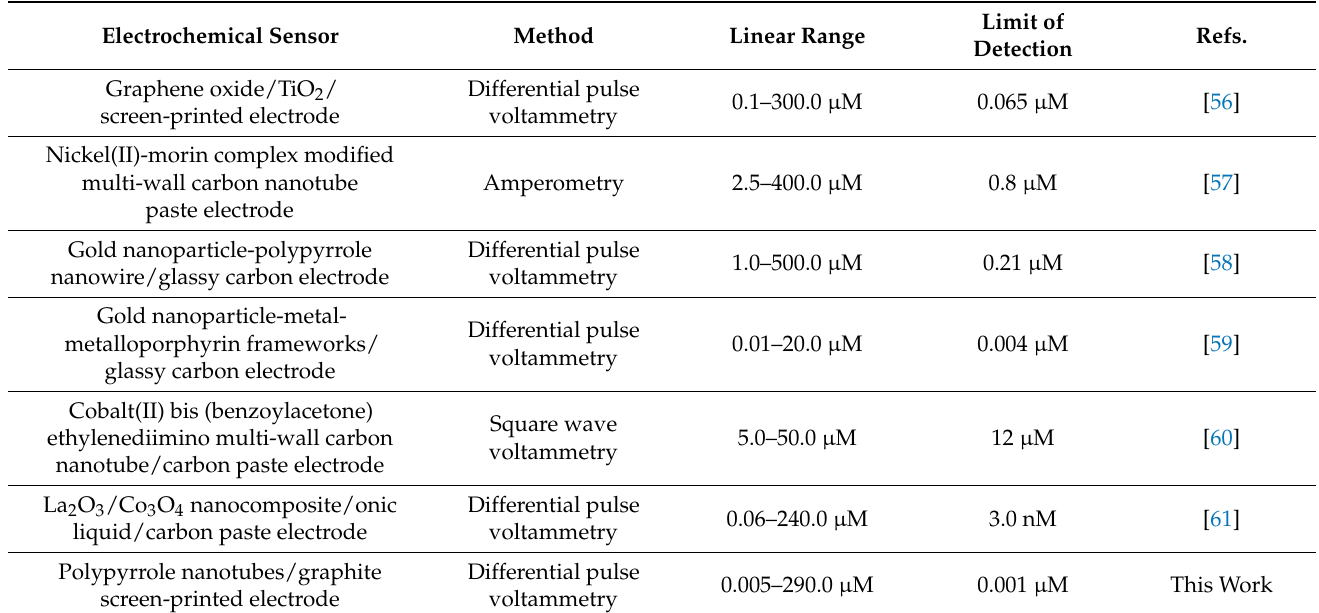
Table 1. Comparing the analytical performance of the PPy NTs/GSPE with other modified electrodes used for hydroxylamine determination.